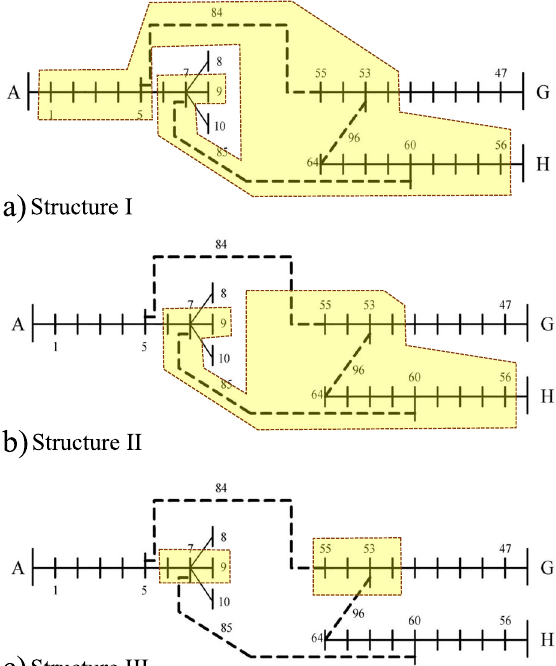
Fig. 9 Recovery index in each